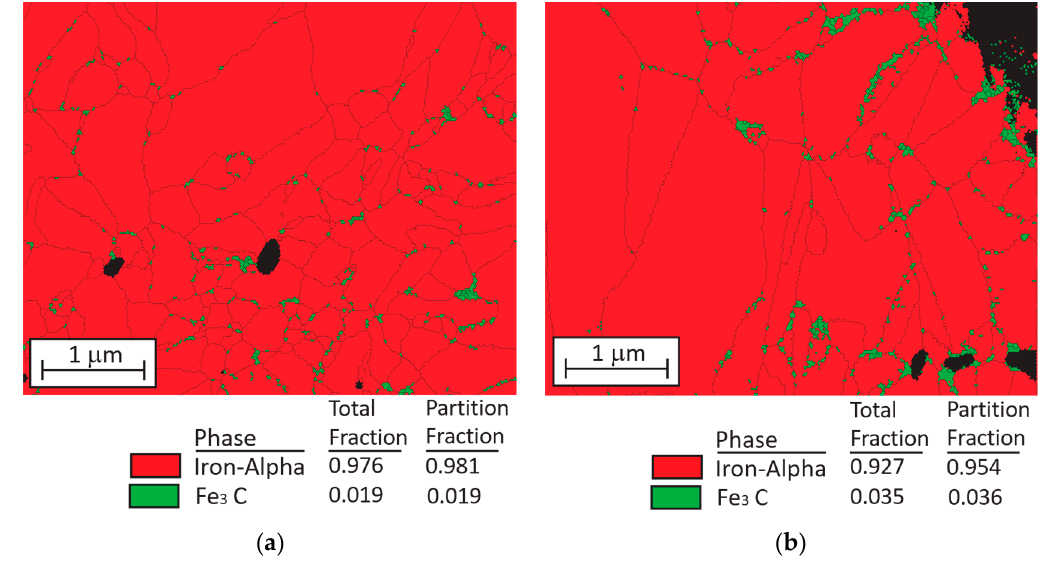
Figure 10. Electron back scatter diffraction pattern (EBSD) analysis results for composite plating layers after heating at 623 K for 7 h. ( a ) Fe–graphite; ( b ) Fe–MWCNT. The α -Fe phase is indicated in red and the Fe 3 C phase is indicated in green.